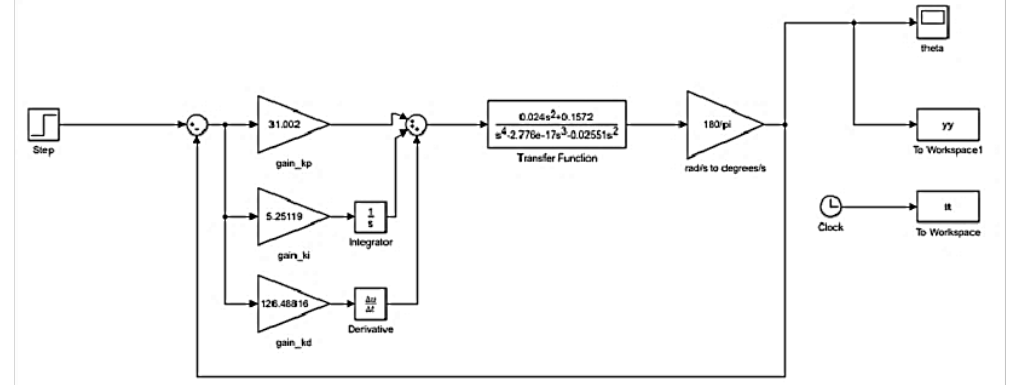
Figure 13. Block diagram of the system with